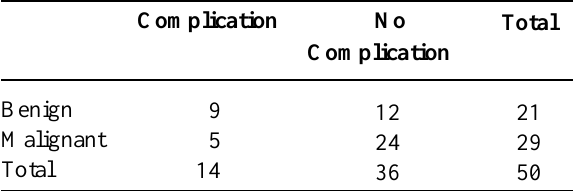
Table 3 – Comparison of percutaneous nephrostomy complications in benign and malignant cases.